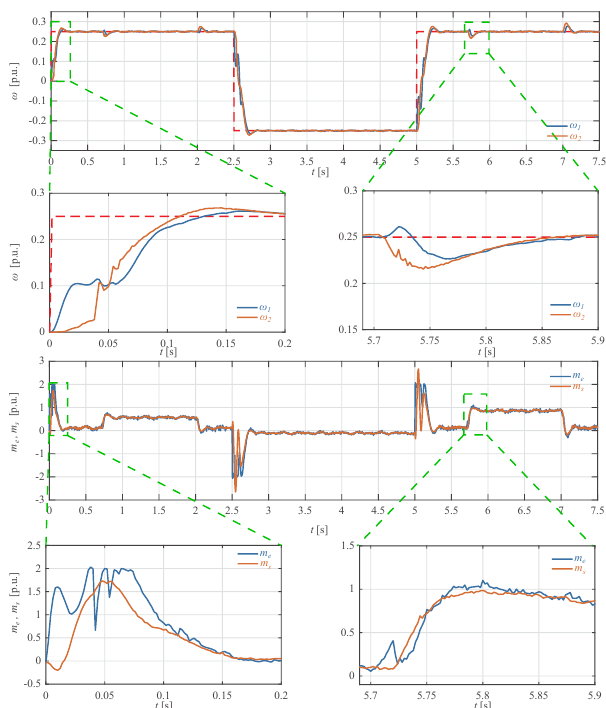
Figure 9. Step response for coefficients of SFC obtained by the ABC algorithm–additional moment of inertia element in mechanical part in the laboratory stand. From top: angular speed of the motor’s shaft and the system output, electromagnetic torque generated by the motor and torsional torque (experimental